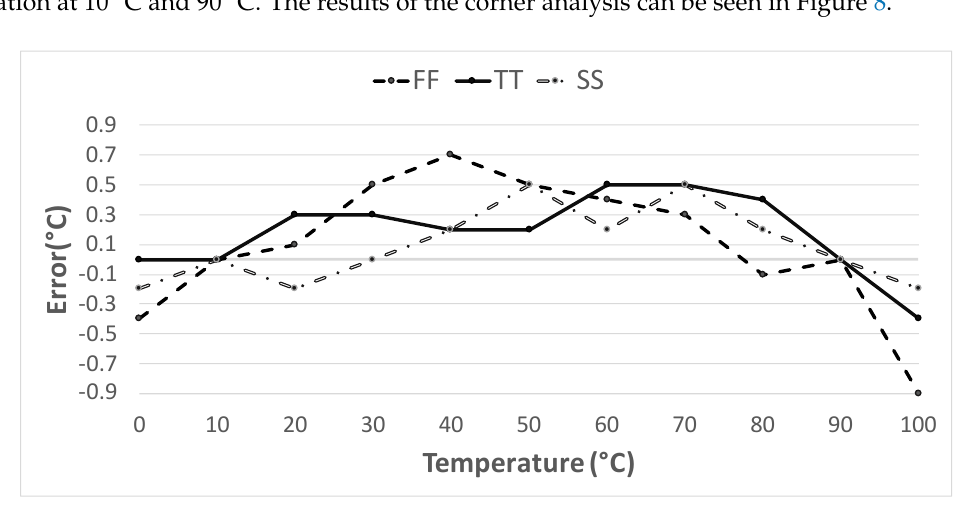
Figure 8. Temperature error considering all process